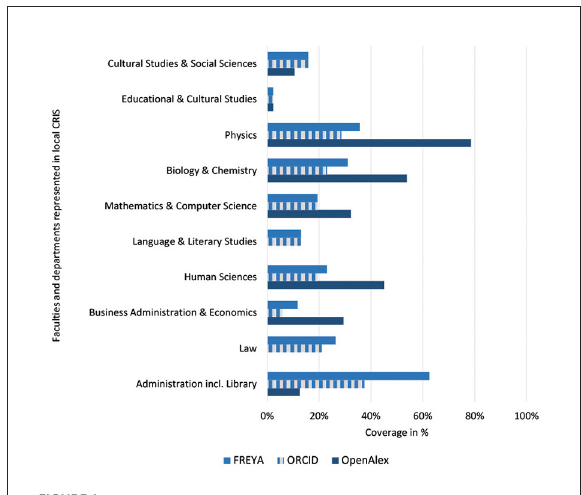
values between 60 and 75%, and Law even reaches full 100%. In contrast to STEM disciplines these researchers are better